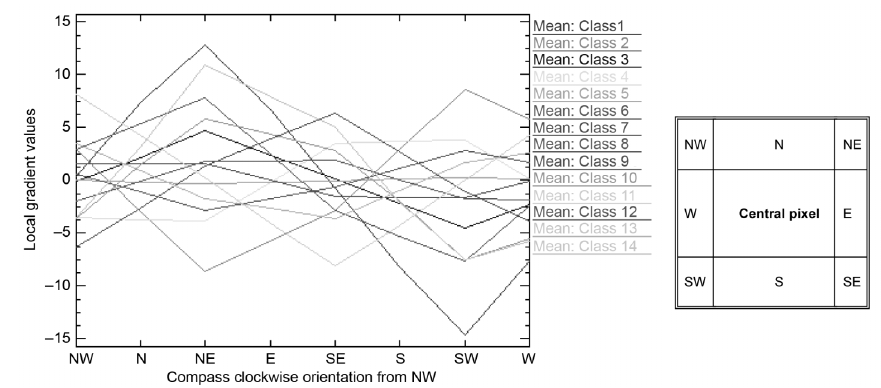
Fig. 4. Sketch of the basic concept for local morphometric